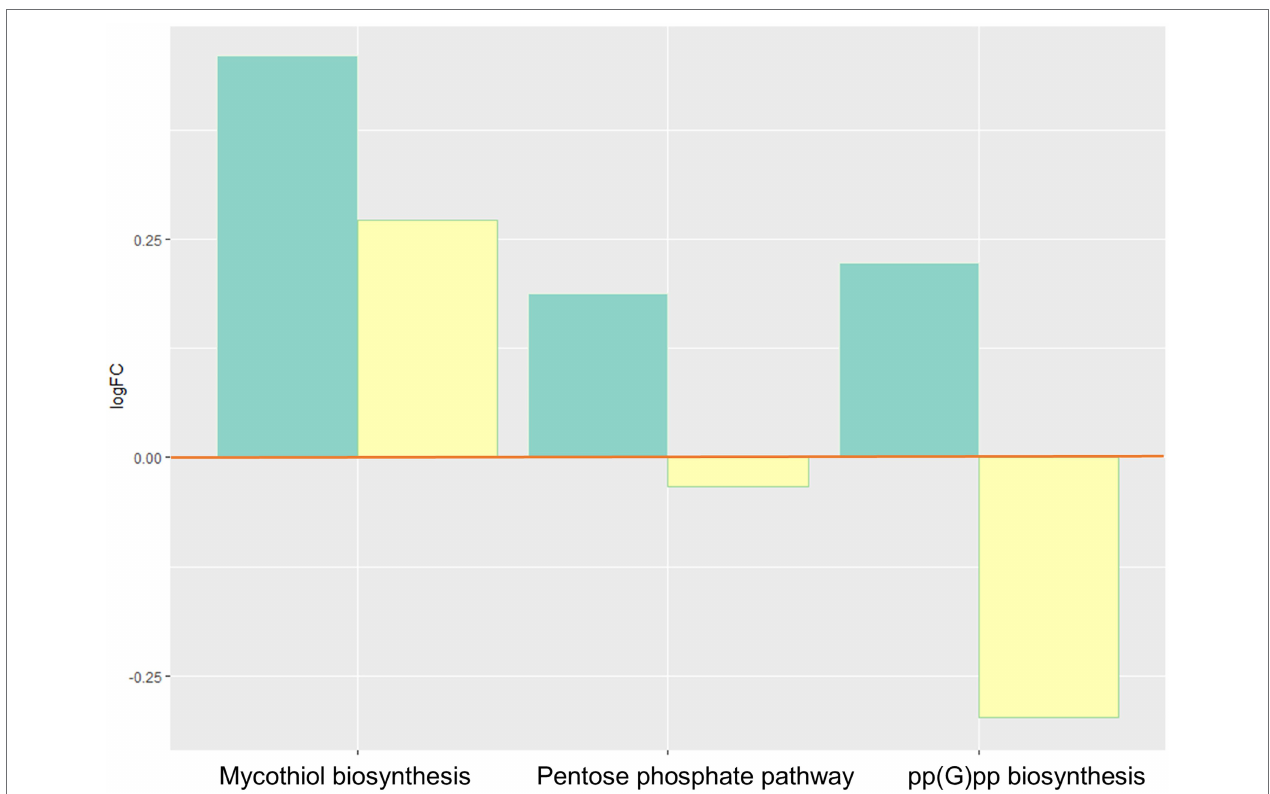
FIGURE 4 | Inferred changes in bacterial oxidative stress responses: mycothiol biosynthesis ( p = 0.0274), pentose phosphate pathway ( p = 0.0047), and pp(G)pp biosynthesis ( p = 0.0429). The bar plots show log2 fold change from paired t tests (means relative to baseline, n = 23): green = after 2 days of heliox saturation; yellow = after